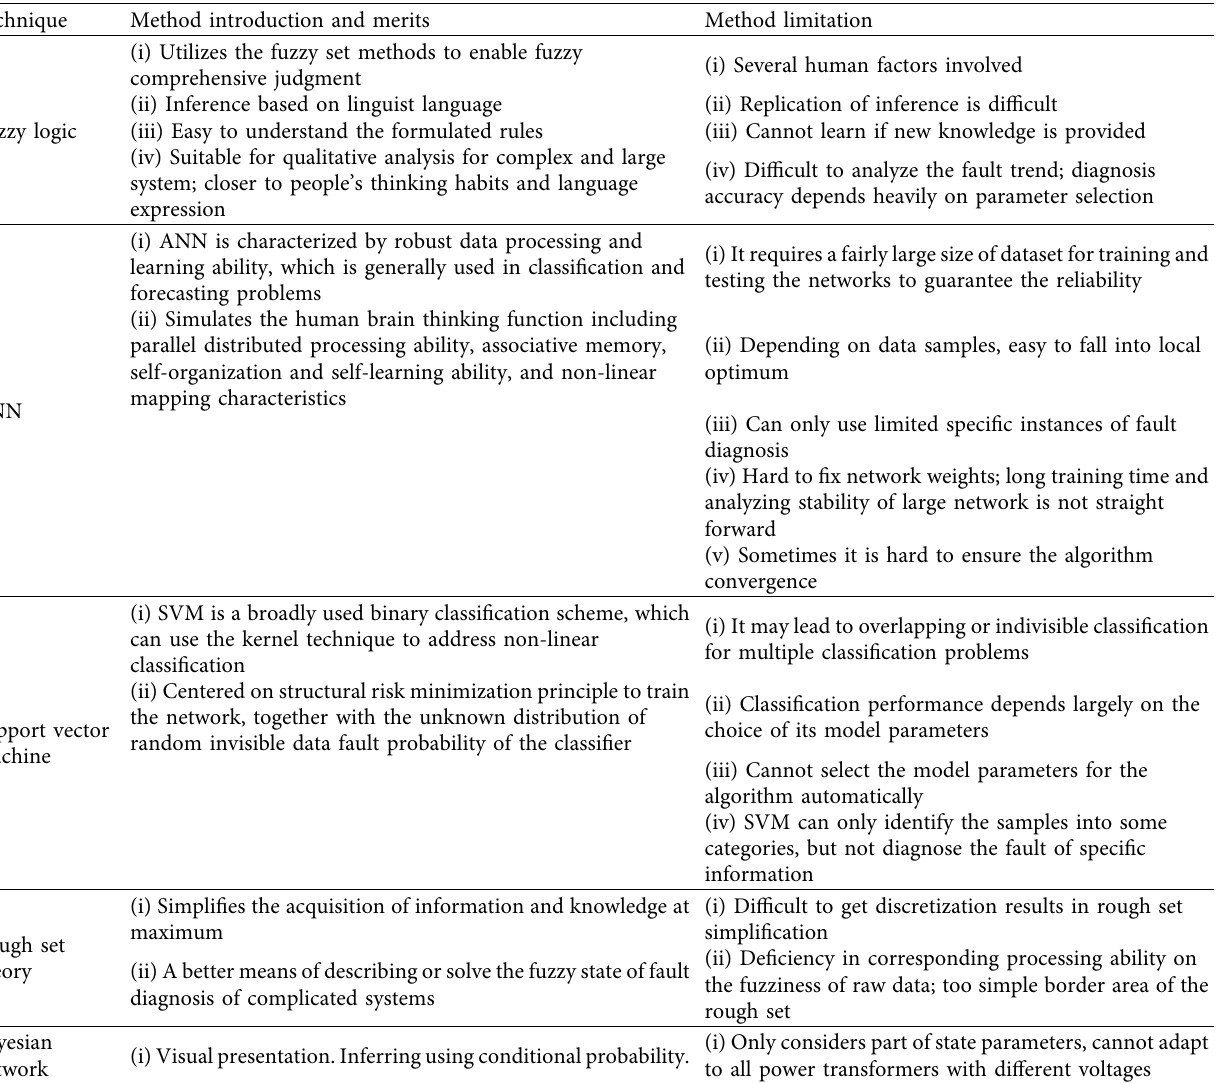
Table 2: Commonly used intelligent diagnosis methods